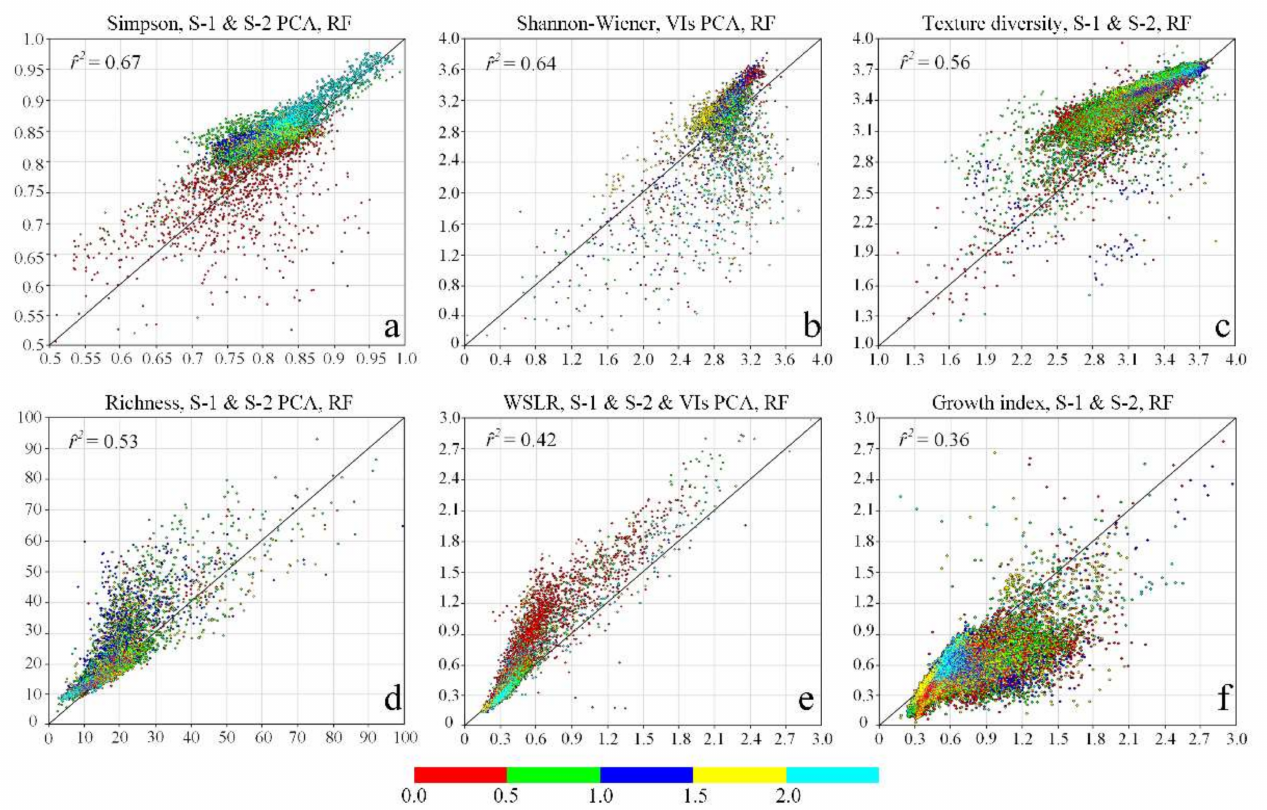
Figure 5. The predicted six diversity indices including ( a ) Simpson, ( b ) Shannon-Wiener, ( c ) texture diversity, ( d ) richness, ( e ) water and soil loss risk (WSLR) and ( f ) growth indices obtained with the random forest (RF) regression and remote sensing data (see Table 2). The X-coordinate is the y values, and the Y-coordinate is the ˆy values. PCA, principal component analysis; VIs, vegetation indices. The colormap indicates the confidence interval of the